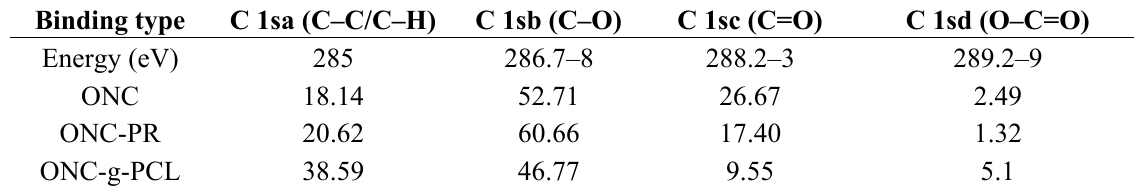
Table 1. C 1s narrow scan XPS spectra for ONC, ONC-PR and ONC-g-PCL.